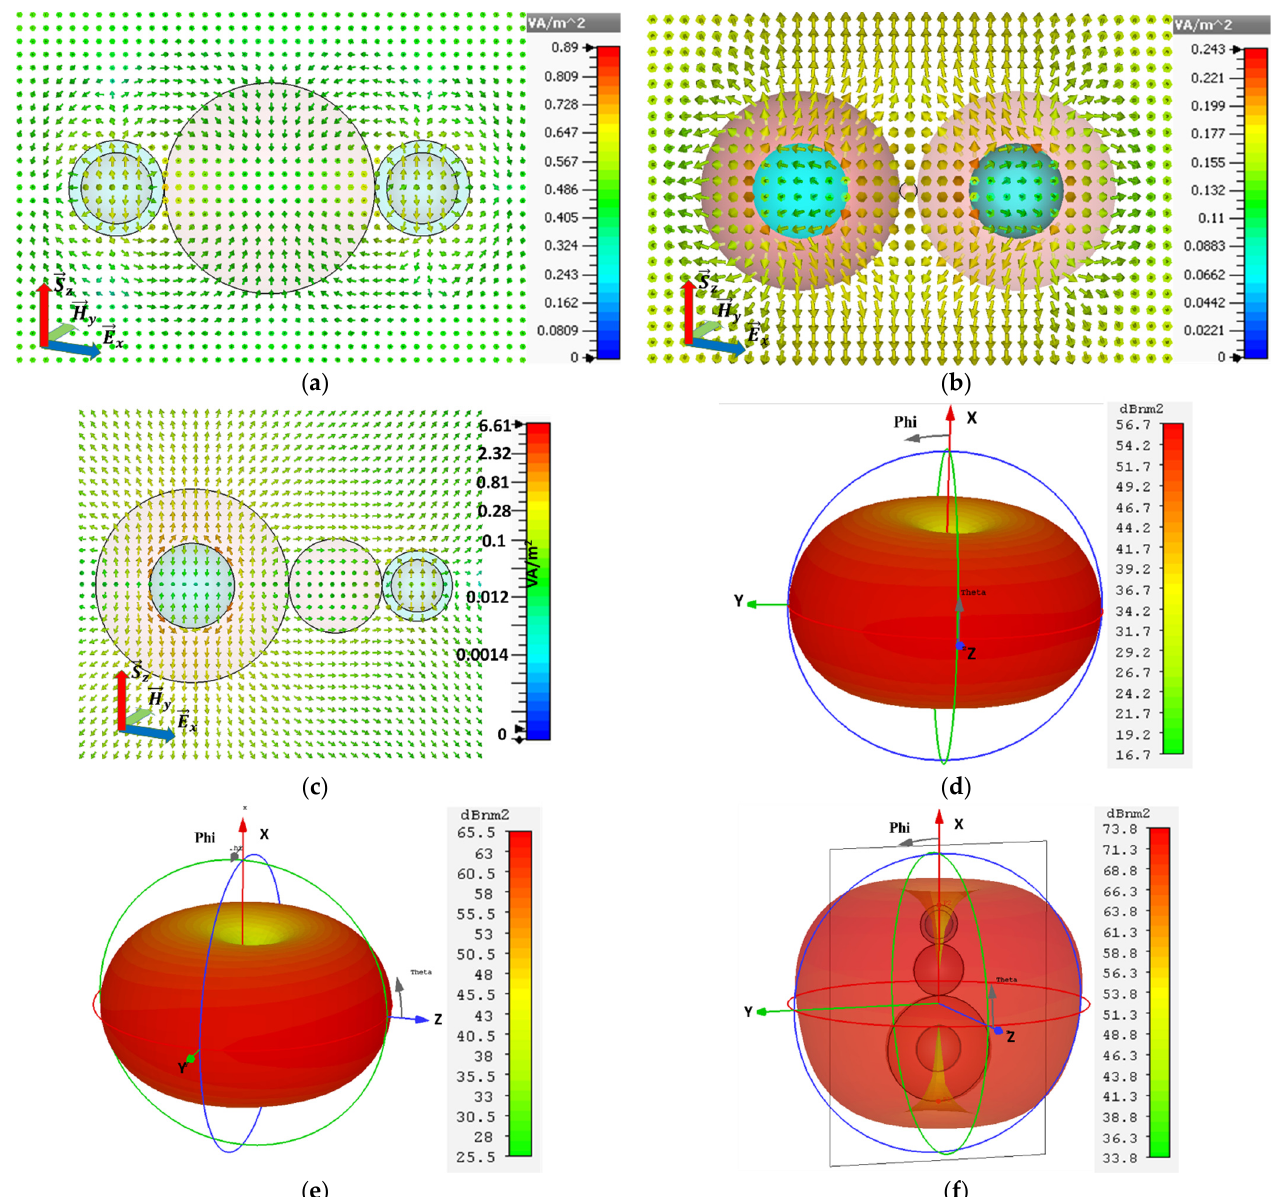
Figure 6. The power flow of ( a ) configuration I, ( b ) configuration II and ( c ) configuration III, whereas ( d – f ) show their far-field patterns at their resonance frequencies, respectively.